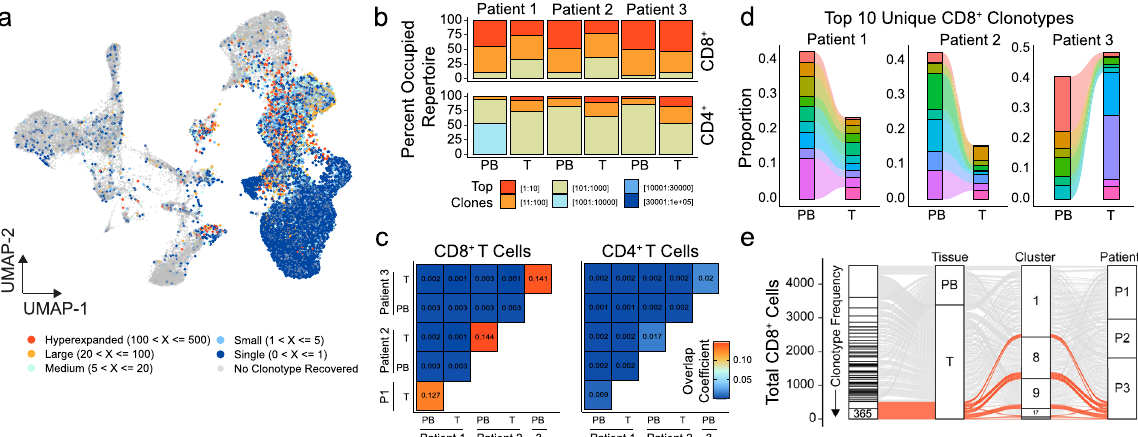
Fig. 2 Clonal dynamics vary by T-cell types and patients. a UMAP of 37,055 primary immune cells overlaid with the frequency of clonotypes assigned by sample identi fi cation. b Occupied repertoire space for the indicated clonotype groups for CD8 + and CD4 + T cells by sample and tissue type in ccRCC patients. c Clonal overlap quanti fi cation by overlap coef fi cient for CD8 + and CD4 + T cells by sample and tissue type in ccRCC patients. d The top ten clonotypes for each patient as a relative proportion of clonotypes for corresponding peripheral or tumor populations. Each color represents a unique clonotype by patient. e Distribution of clonotypes by tissue, UMAP cluster and ccRCC patient with highlighted (red) the top two clonotypes, comprising tumor-speci fi c clonotypes across all clusters.